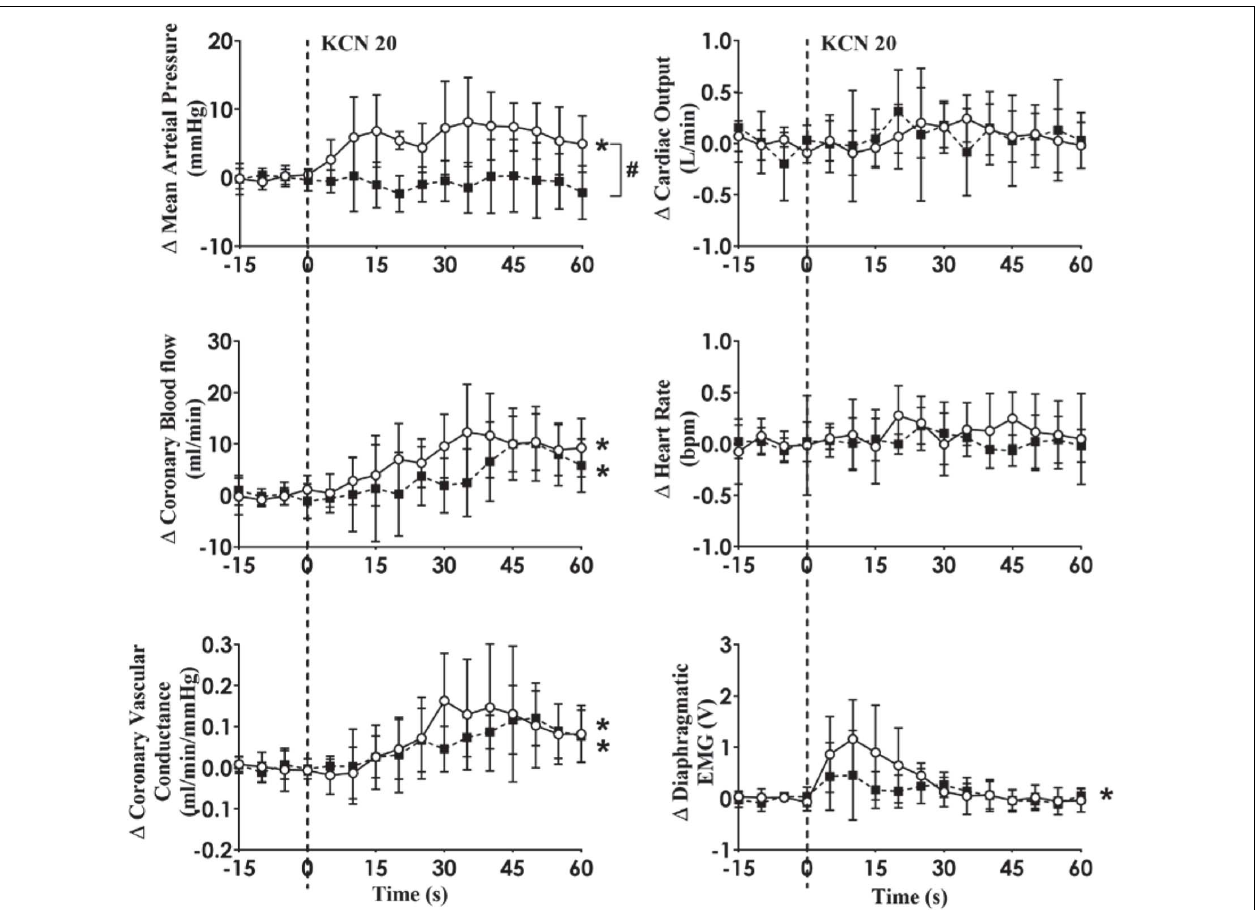
FIGURE 5 | Absolute change in cardiovascular variables to carotid body activation before and after muscarinic receptor blockade (Atropine sulfate; 8 mg bolus followed by 24 mg/h infusion for 30 min) in conscious sheep with heart failure. The heart was paced at a constant rate such that the heart rate was unchanged. The open circles and solid line represent before atropine, and filled squares and interrupted line is after atropine responses. Results are mean ± SD. * p < 0.05 denotes a significant effect of time (ANOVA, *effect within 1 min time after injections; # significant interaction effect of time × group). TABLE 3 | The effect of intravenous propranolol infusion on resting hemodynamic variables. Control Heart failure